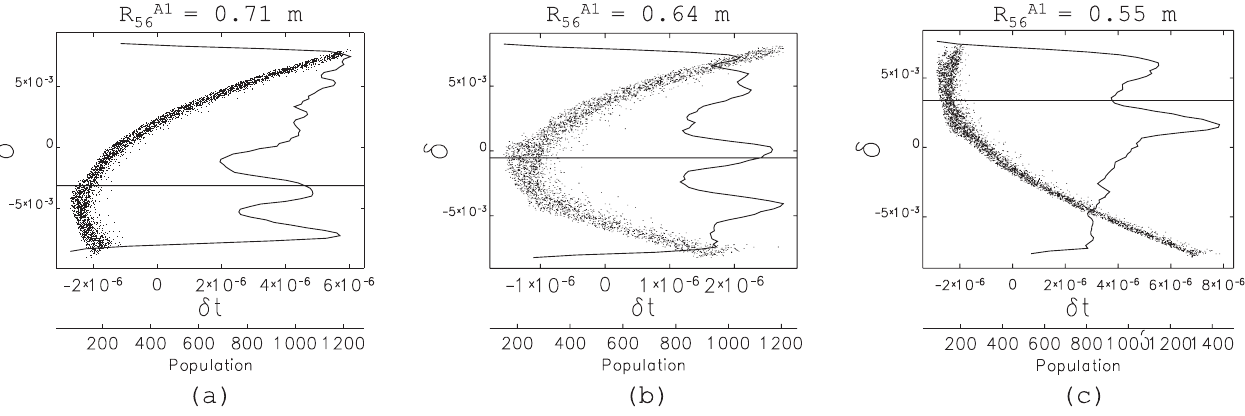
FIG. 10. Plots from simulation of the longitudinal phase space overlayed with the momentum spectrum. Where δ and δ t are normalized values of momentum and time respectively. From left to right shows the progression of: (a) undercompression, (b) full compression, and (c) overcompression within BC1. The horizontal line running across the plot shows the calculated location where the spike and depletion in each spectrum should